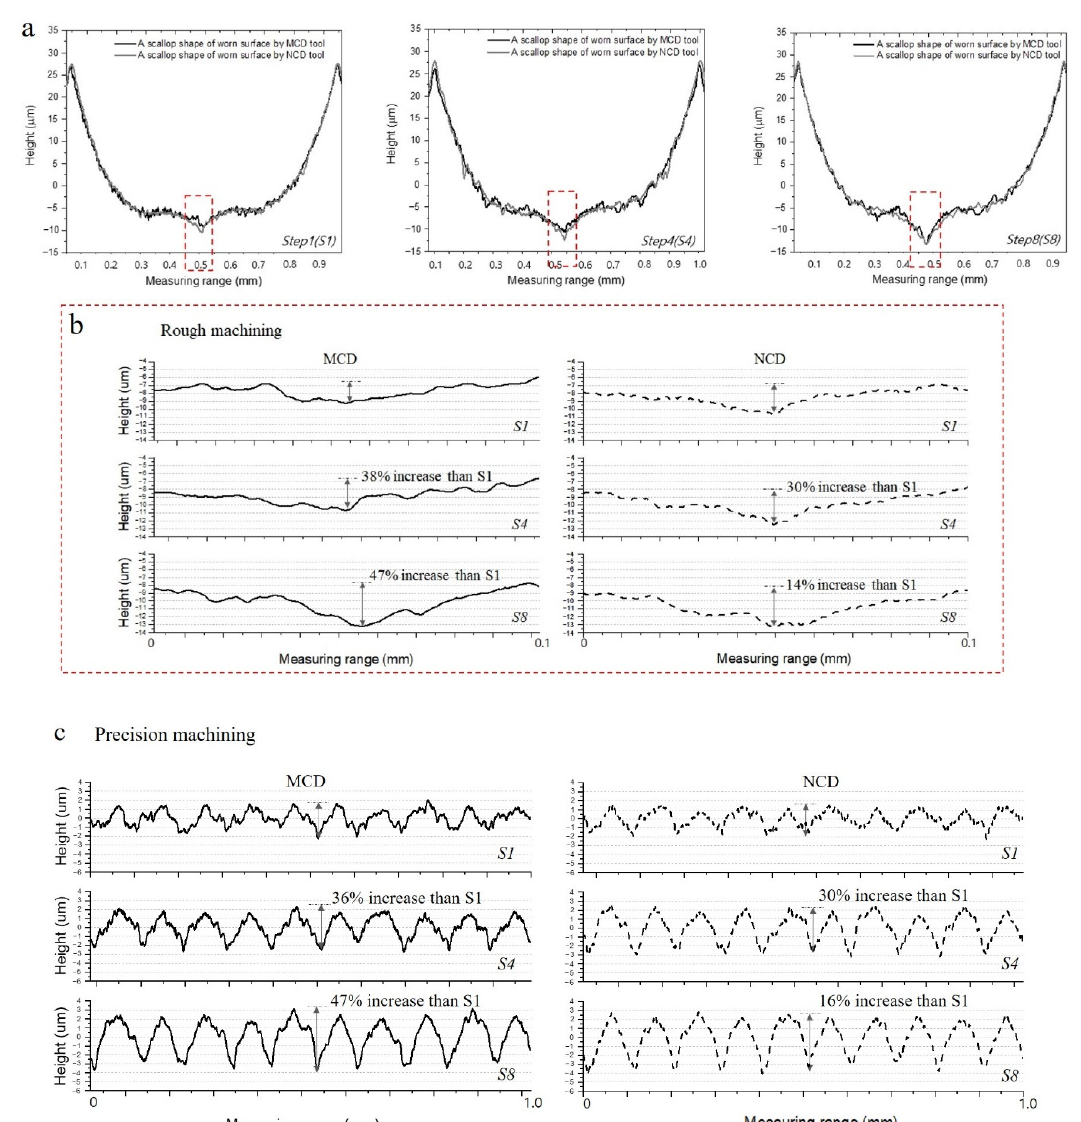
Figure 15. Surface profiles machined using MCD and NCD-coated tools. ( a ) Magnified graphs of scallops on machined surface during rough machining, ( b ) magnified profile of the groove within the red box area in ( a ), and ( c ) magnified graphs of machined surface during precision machining. The coating grains and graphite fragments that came off changed the profile of the machined surface scallop and finally changed the surface roughness during precision cut- ting. The abrasive wear is often considered as a type of cutting because the generation of the valley (groove), a representative abrasive wear, is similar to cutting process [24]. The profile shown in Figure 15a indicates an inaccurate hemisphere shape of the cross-section of the ball endmill. The section of approximately 0.25 mm around the rotation axis of the tool showed a valley shape, and the groove became deeper as the cutting length increased. The rough machined surface was re-machined during precision cutting. Thus, the change rate of the valley depth according to the cutting length was analysed after enlarging the length (0.1 mm) around the rotation axis of the scallop of the machined surface during